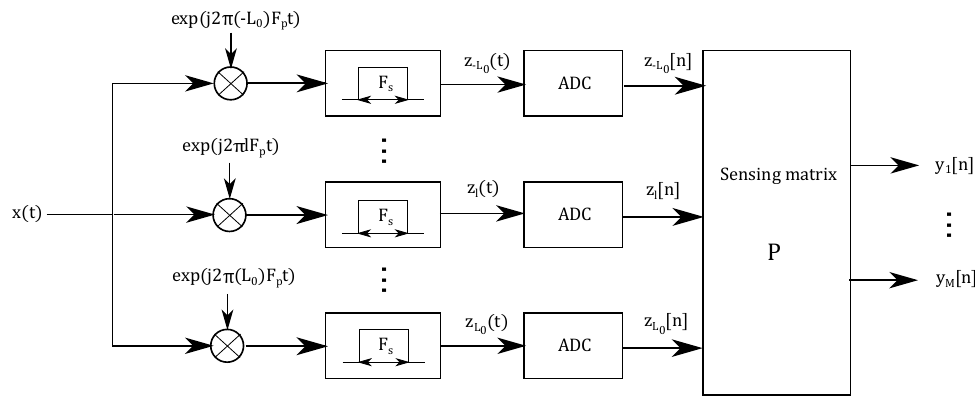
Figure 2. Nyquist-equivalent model of